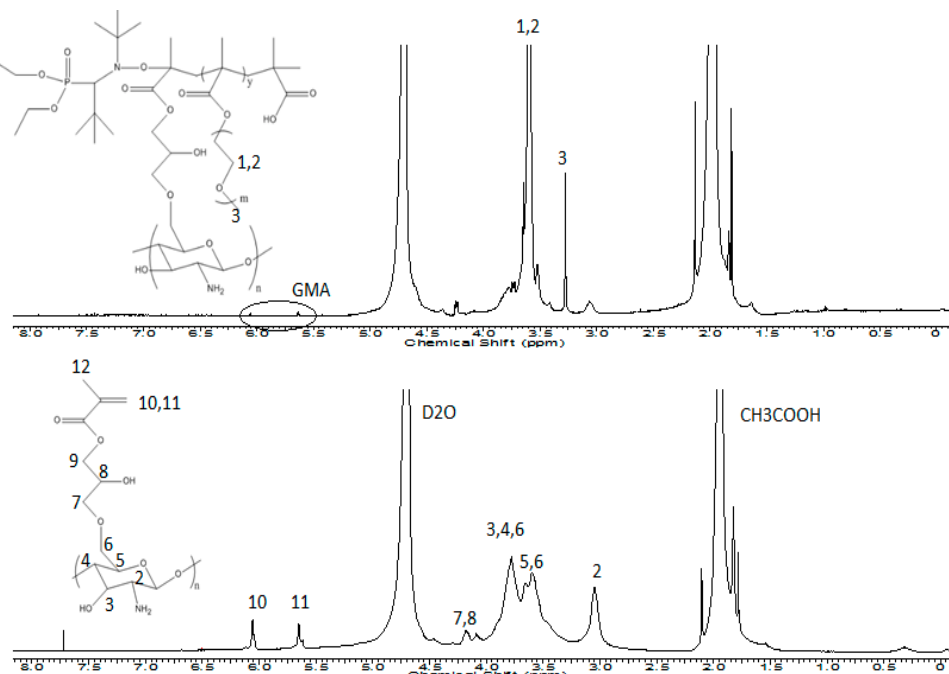
Figure 8. 1 H NMR of CTS ‐ g ‐ GMA ‐ PPEGMA ( Top ) and CTS ‐ g ‐ GMA ( Bottom ).